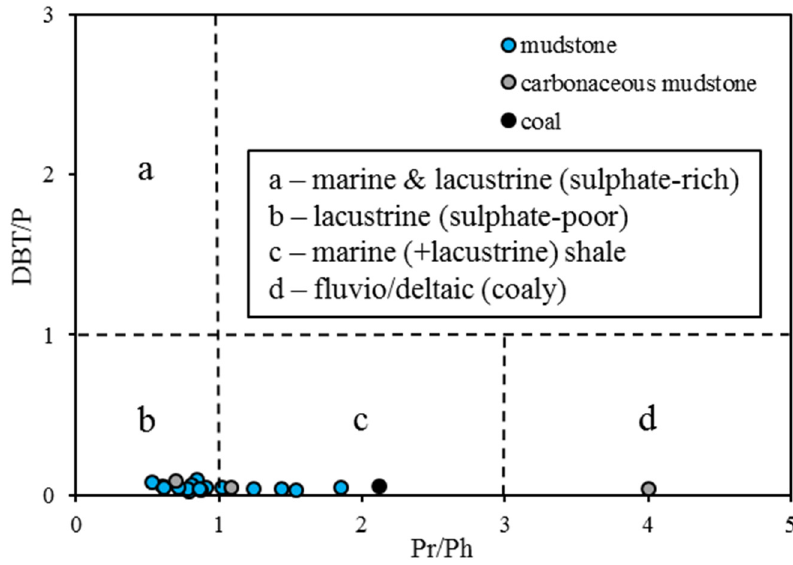
Figure 8. Cross plot of DBT/P ratios vs. Pr/Ph (after Hughes et al., 1995